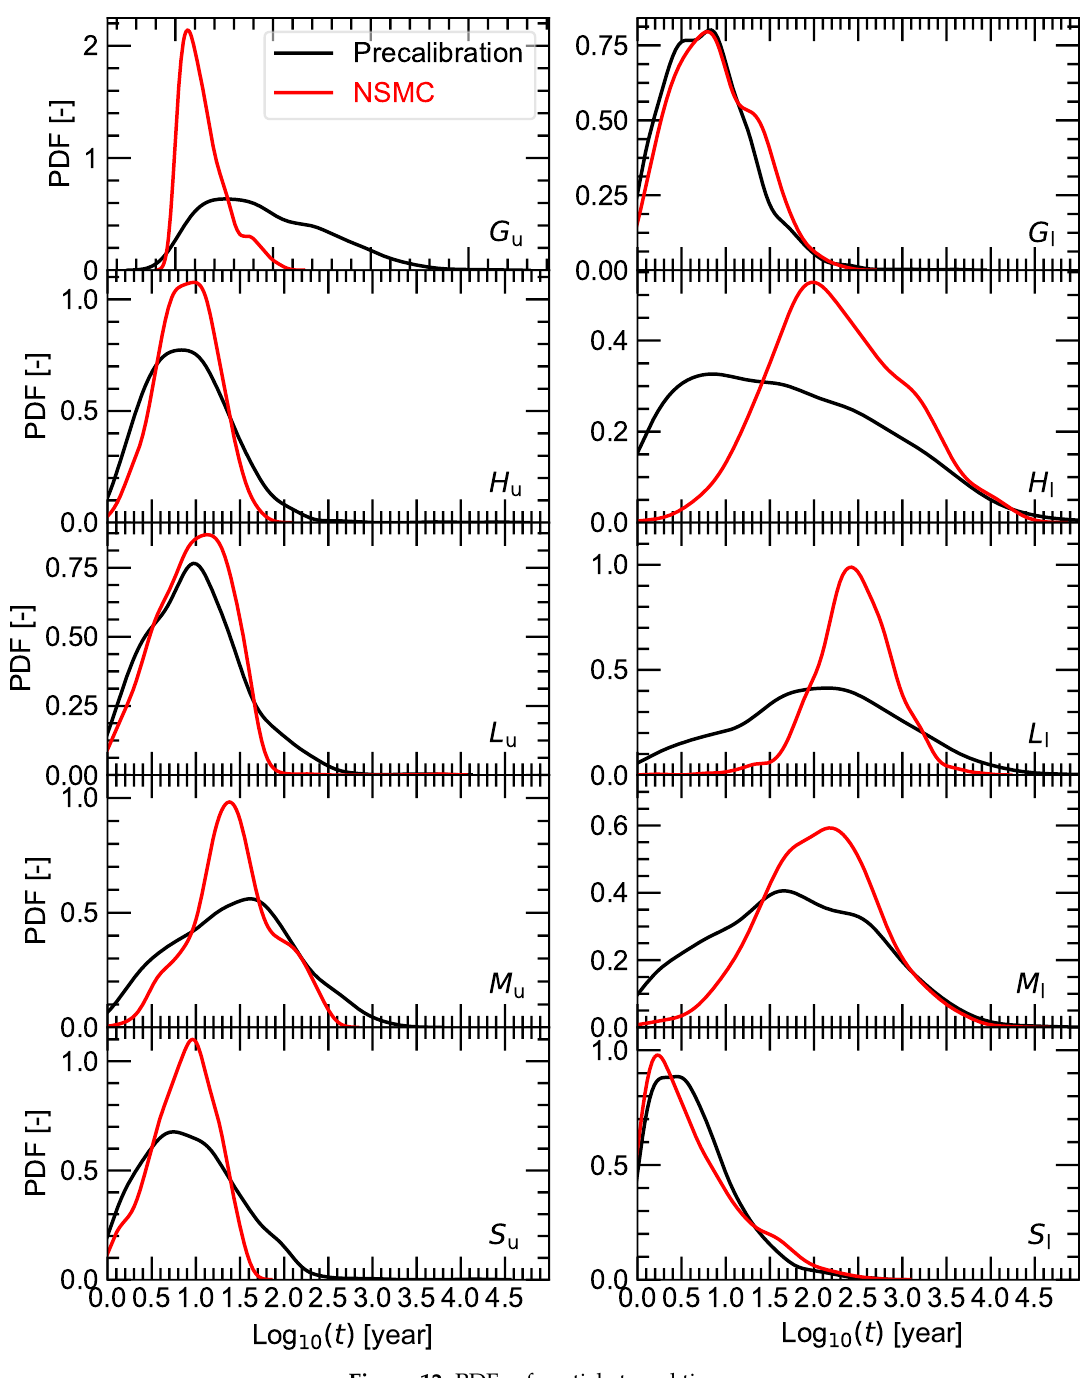
Figure 12. PDFs of particle travel